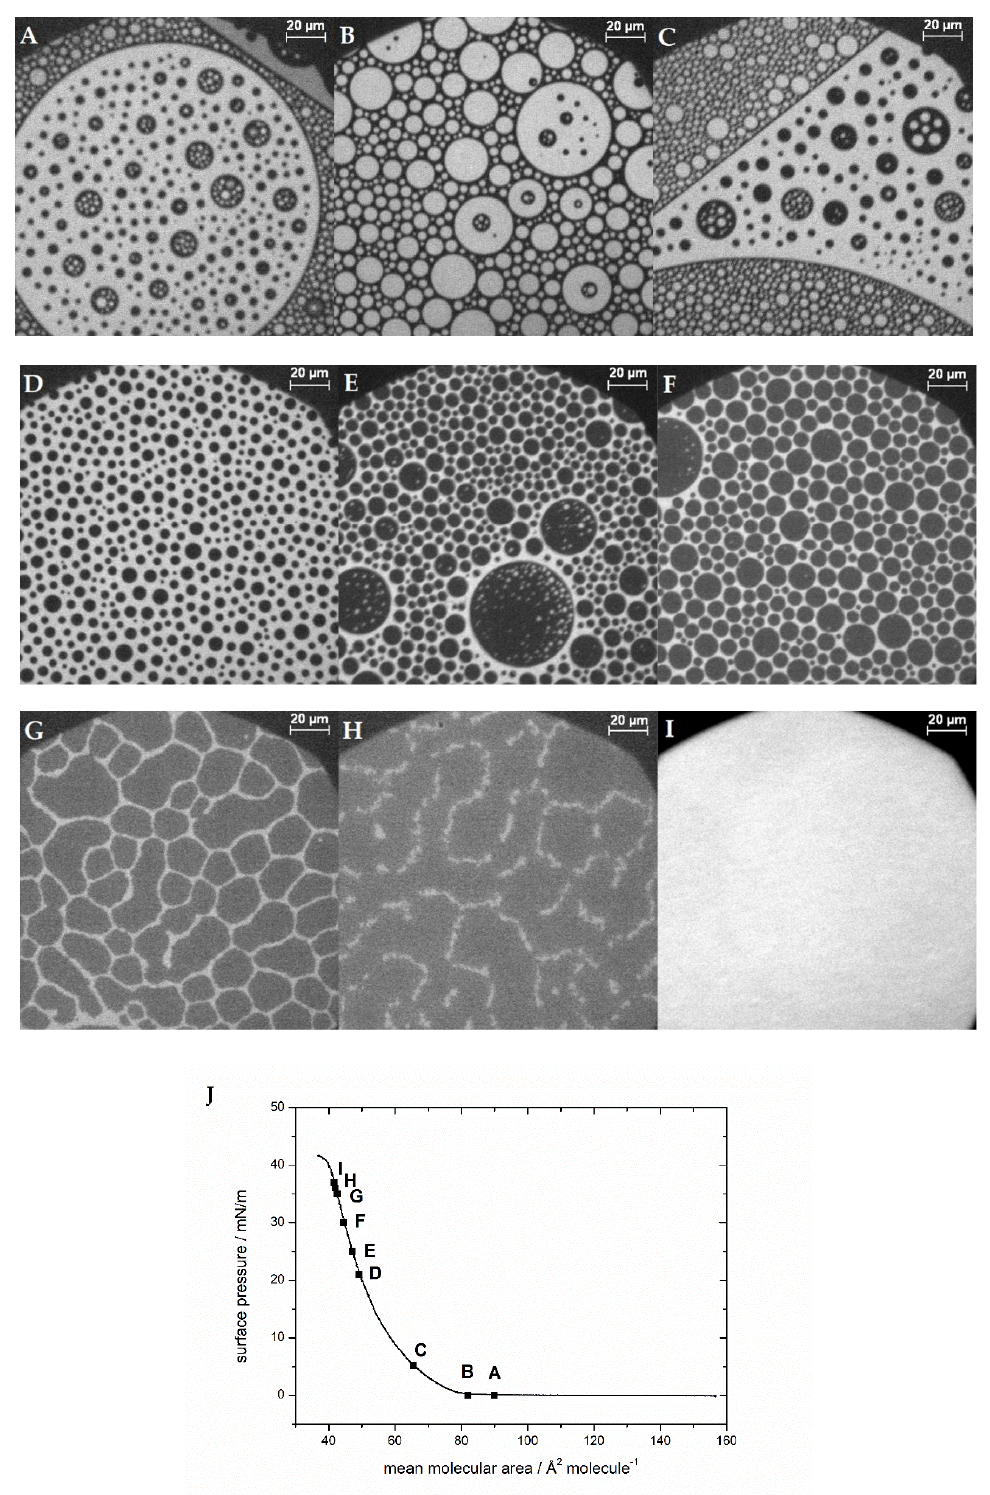
Figure 4. Representative fluorescence microscopy images of the compression behavior of the lipid monolayer with 44% cholesterol and 0.05 mol% 1,2-Dihexadecanoyl- sn -glycero-3-phosphoethanol- amine- N -(lissamine rhodamine B sulfonyl) (Rh-DHPE) on a HEPES–NaCl buffer subphase at ca. ( A , B ) 0 mN/m, ( C ) 5 mN/m, ( D ) 21 mN/m, ( E ) 25 mN/m, ( F ) 30 mN/m, ( G ) 35 mN/m, ( H ) 36 mN/m, and ( I ) 37 mN/m. The scale bar represents 20 µm. ( J ) Compression isotherm.